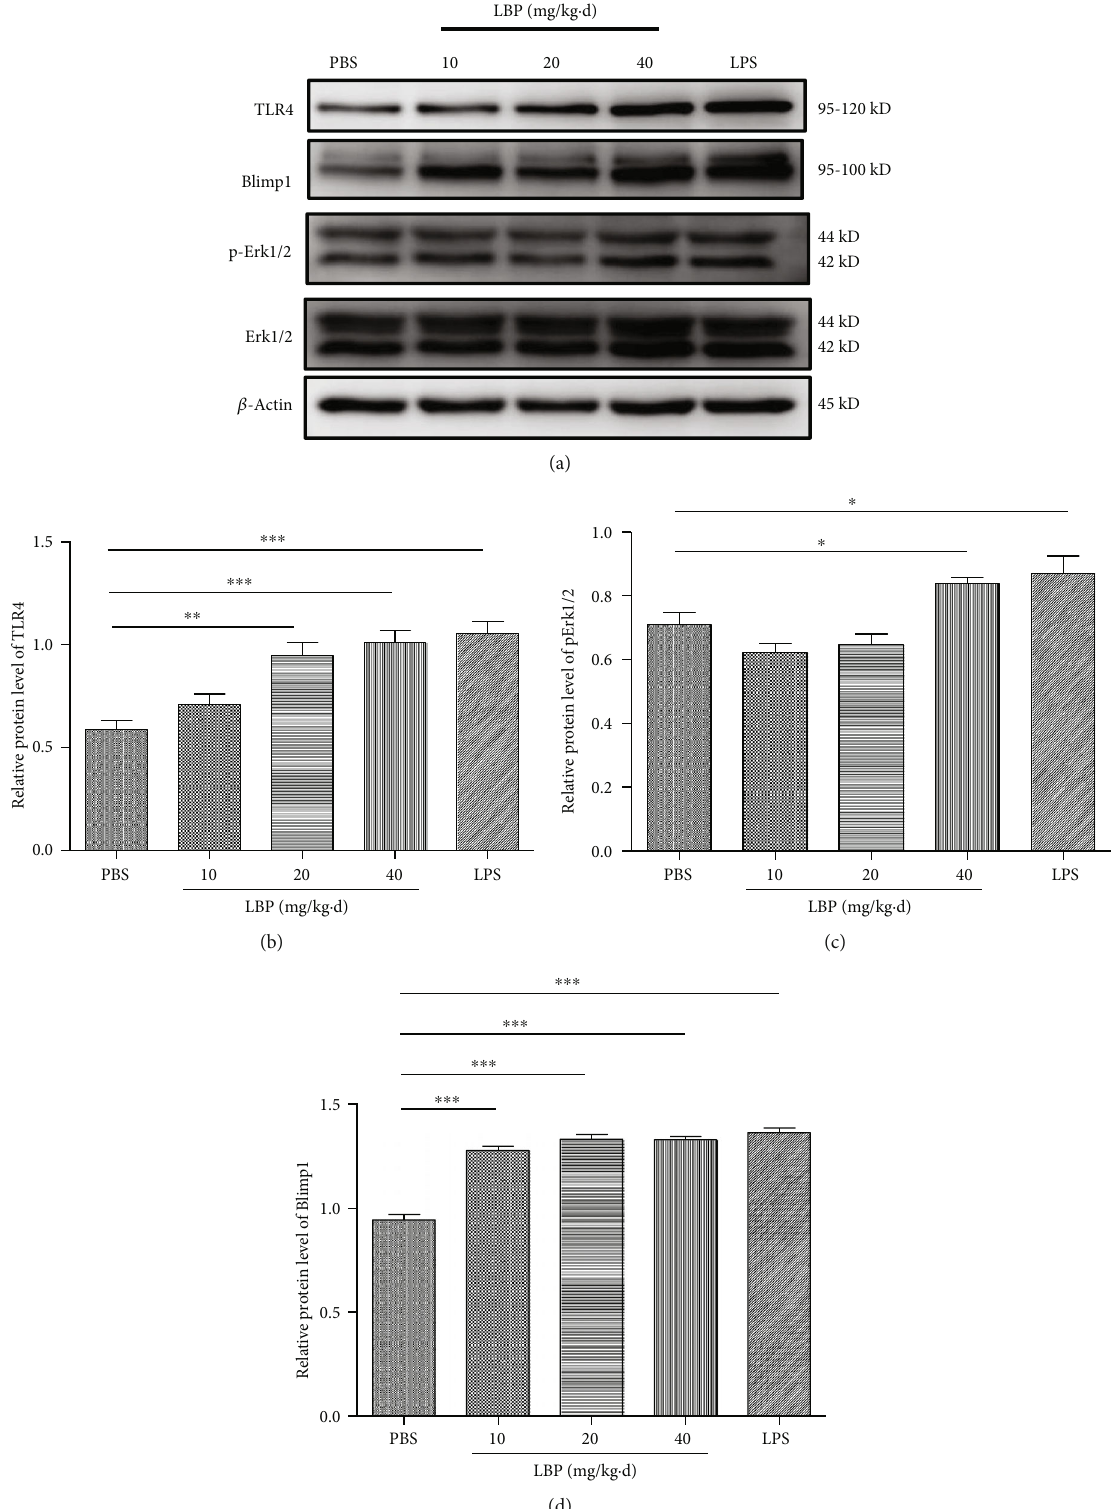
Figure 7: LBP induces the expression of TLR4, Erk1/2, and Blimp1 in DCs from a mouse spleen in vivo study. Both LBP (0, 10, 20, and 40mg/kg) and LPS (1 mg/kg) were administered intraperitoneally to C57BL/6 mice in three groups. After 7 days, mouse splenic DCs were isolated and examined for TLR4 (b), Erk1/2 (c), and Blimp1 (d) expression by Western blot. Values are the mean and SD of 5 independent experiments. ∗ P < 0 : 05 , and ∗∗ P < 0 : 01 , and ∗∗∗ P < 0 : 001 versus